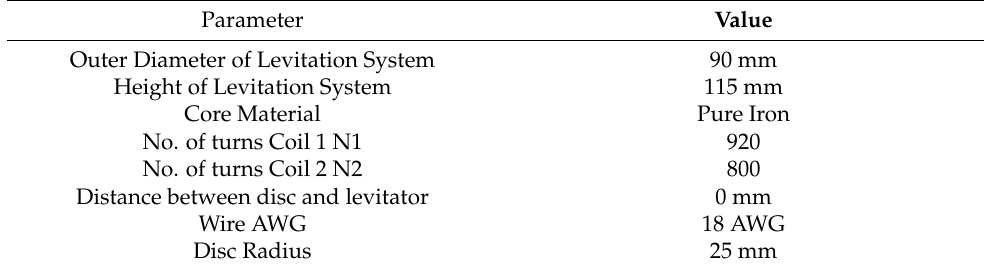
Figure 7. Comparison of performance of the materials. ( a ) Comparison of core materials: Levitation Force (N). ( b ) Comparison of core materials: Restoration Force (N). Table 1. Specifications of the levitation